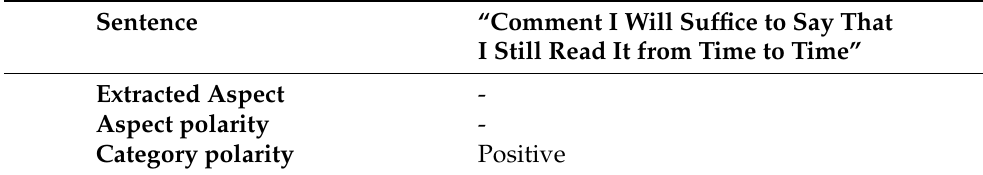
Table 5. Third type of error: unlabelled sentence. Second example.